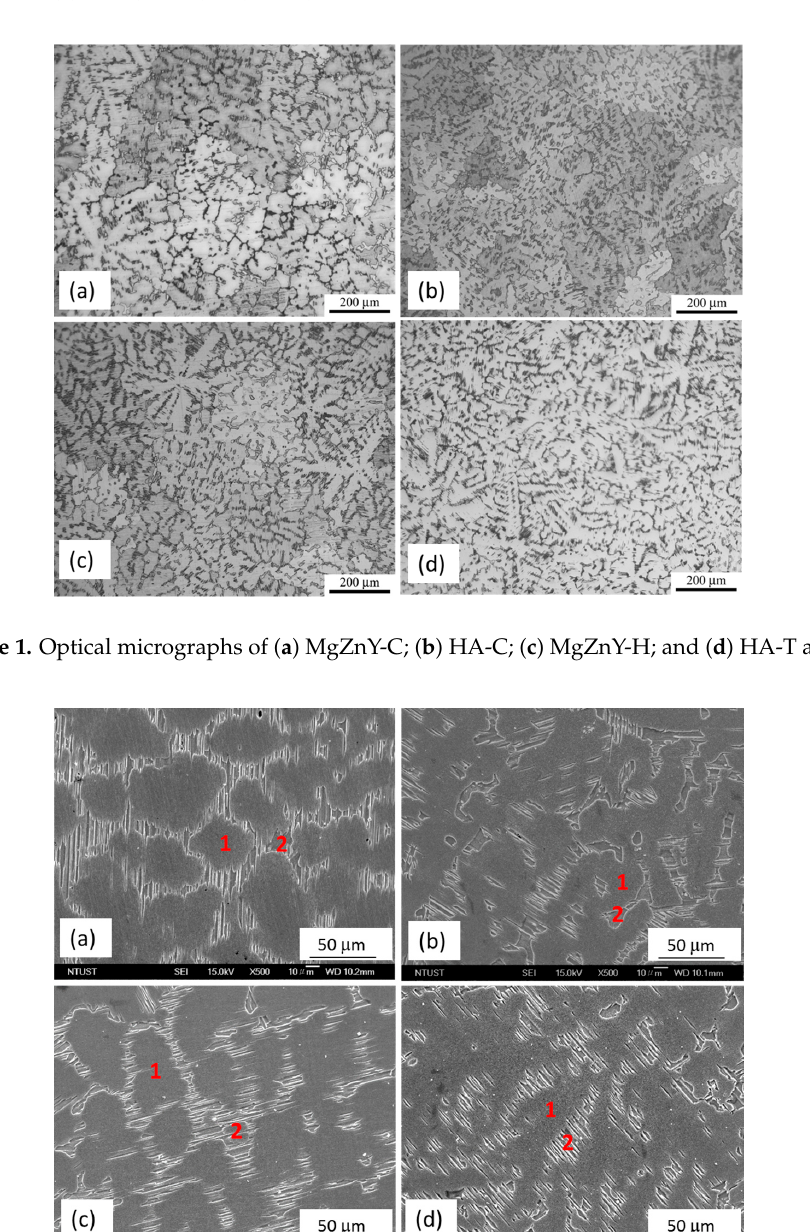
Figure 2. Scanning electron microscopy (SEM) micrographs of ( a ) MgZnY-C; ( b ) HA-C; ( c ) MgZnY-H; and ( d ) HA-T alloys.